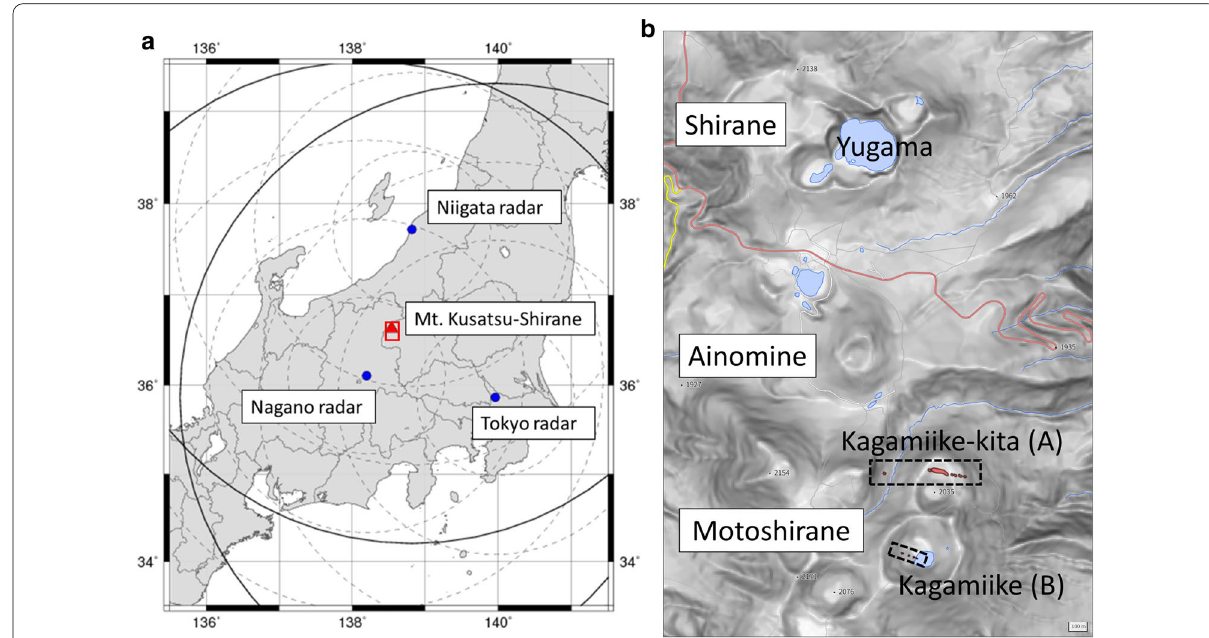
Fig. 1 a Location map of three JMA weather radars (blue dots) around Mt. Kusatsu-Shirane (red triangle). Dashed concentric circles show 100, 200, and 300 km from each radar site, and solid circles show the maximum range of the radars (400 km). b Detailed map around Mt, Kusatsu-Shirane. This area corresponds to the red rectangle in a . Two dashed rectangles show the crater rows [Kagamiike-kita ( A ) and Kagamiike ( B )] of the 2018 eruption. This figure was created based on the map created on the Geospatial Information Authority of Japan website (https:// maps. gsi. go. jp/